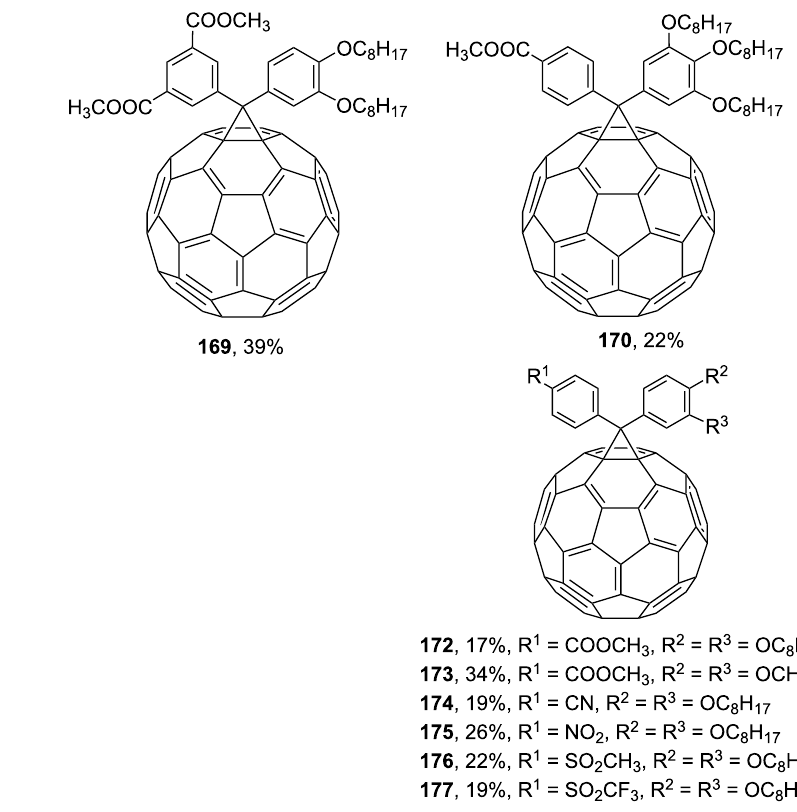
Figure 12: Polysubstituted diphenylmethanofullerenes 169 – 177 .